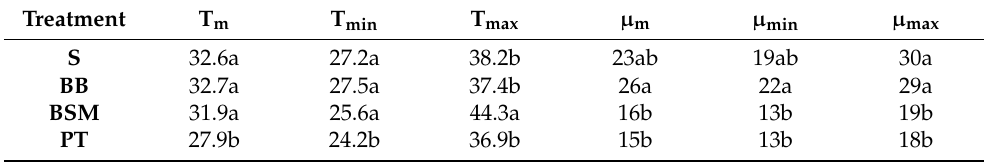
Table 3. Soil temperature and soil moisture values.